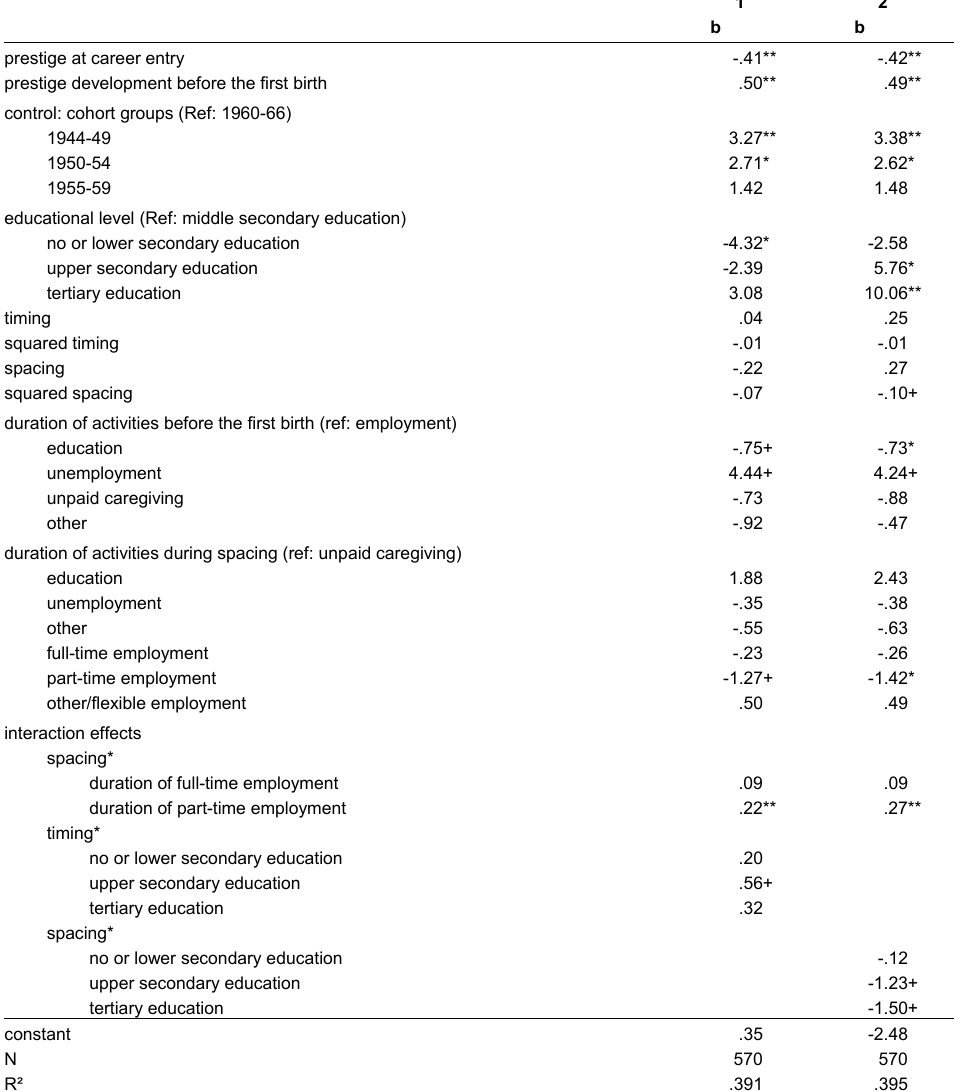
Table 7 : impact of education-specific timing and spacing on prestige at age 45